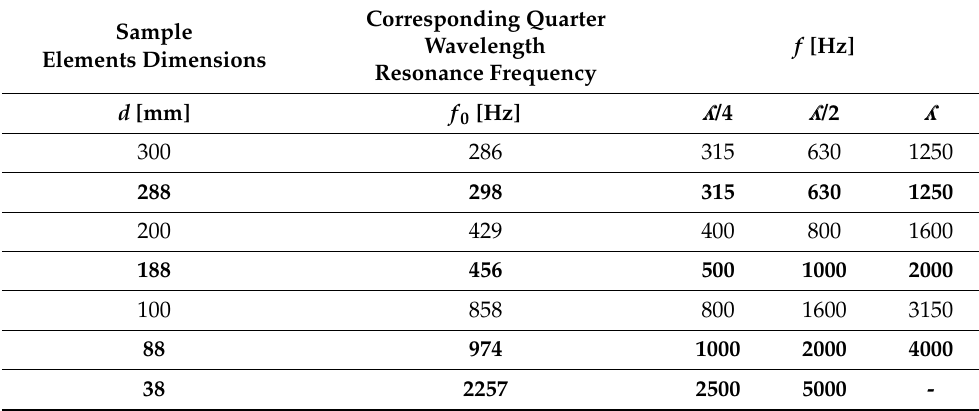
Table 2. Evaluation of the wavelengths in relation to the dimensions of the sample elements. The inner dimensions of the boxes are indicated in bold. L is the wavelength corresponding to the third-octave band f when d = L